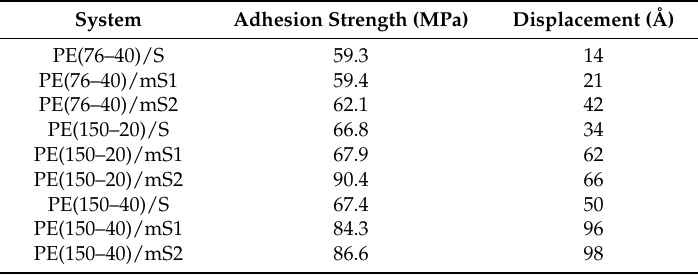
Table 1. The shear strength and the corresponding displacement of the PE/S interfaces calculated at 300